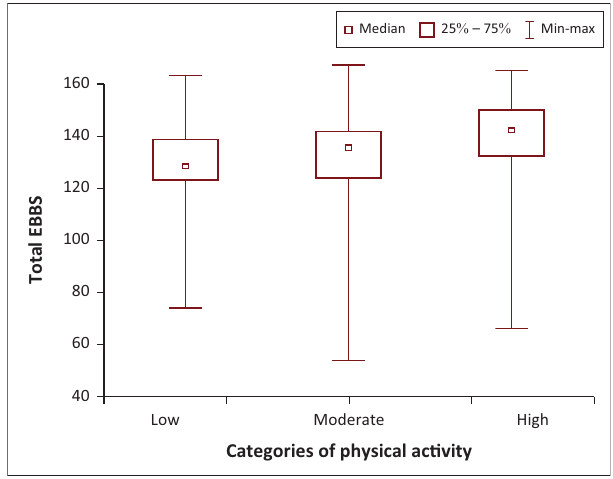
FIGURE 4: Box and whisker plot of scores on the Exercise Benefits and Barriers Scale for all students classified as undertaking low, moderate or high physical activity on the International Physical Activity Questionnaire-short ( n =